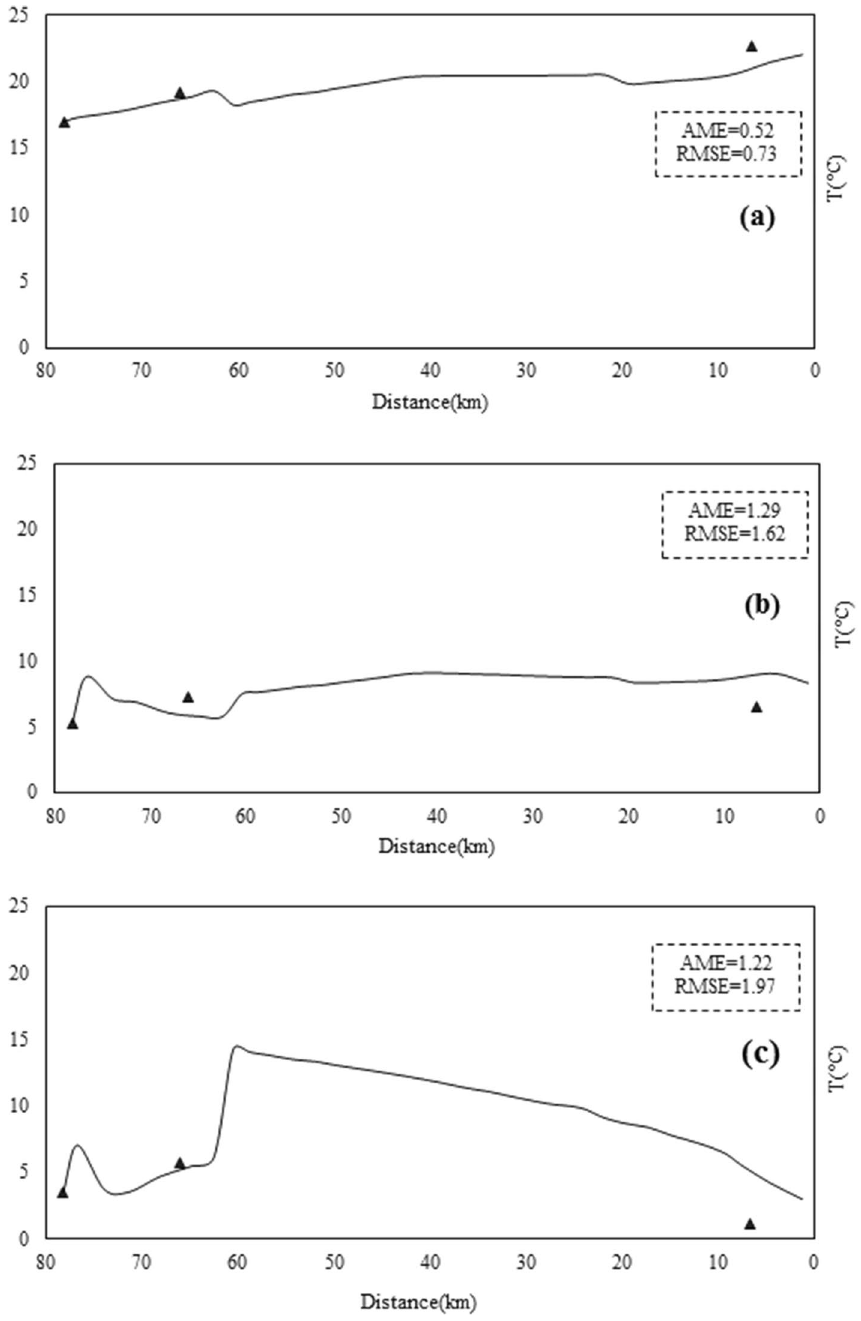
Figure 6. Total Temperature of Sarouq River in ( a ) spring, ( b ) autumn, ( c ) winter after